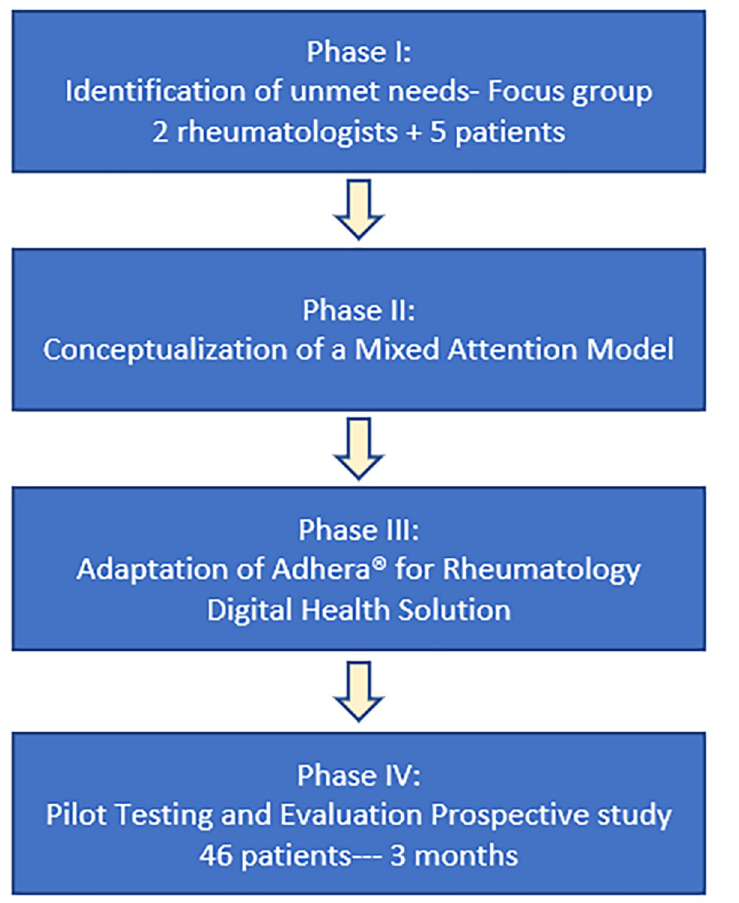
Fig 1. Phases of design and implementation of the Digireuma